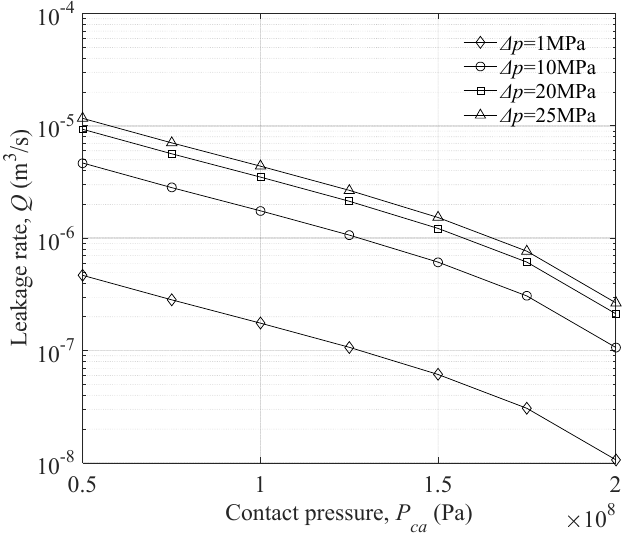
Figure 18. The influence of the contact pressure on the leakage rate.